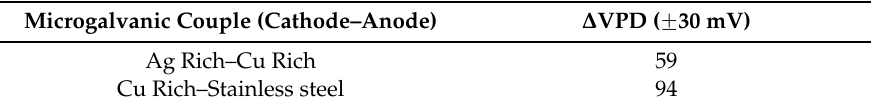
Table 4. Relative VPD in mV of the Cu-Ag-In-Ti sample. The first phase/metal is the more positive of